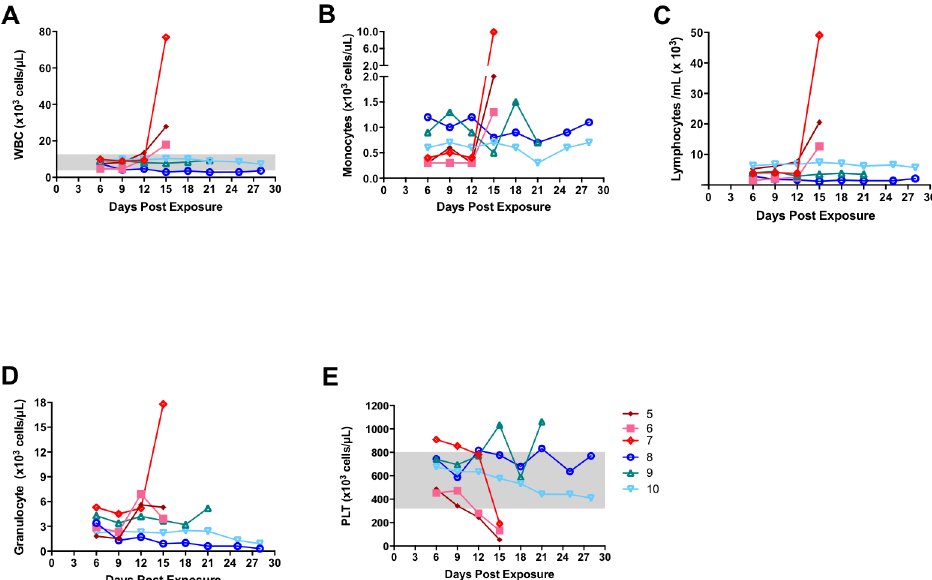
Fig 7. Select hematology from marmosets, some treated, then exposed to intranasally to low dose monkeypox virus. Prior to challenge, animal 5 was treated with an isotype control antibody, while animals 6 and 7 were treated with PBS. Animals 8, 9, and10 were treated with monkeypox targeted antibody. White blood cells (WBC) (A), lymphocytes (B), monocytes (C) and granulocytes (D) were elevated, and platelets (PLT) (E) decreased in most of the control animals whereas treated animals did not vary much from earlier time points. Data was collected using a Coulter AcT